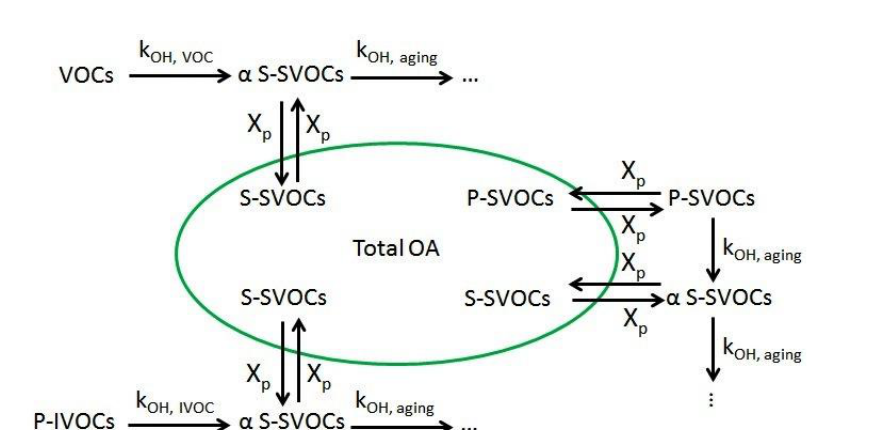
Figure 1. Schematic of the chemical pathways leading to the formation of SOA in the box model, in which α is the SOA yield, k OH,VOC and k OH,IVOC are the rate constants of a VOC or an IVOC species, respectively, for oxidation by OH radicals, and X p is the particle-phase fraction of a